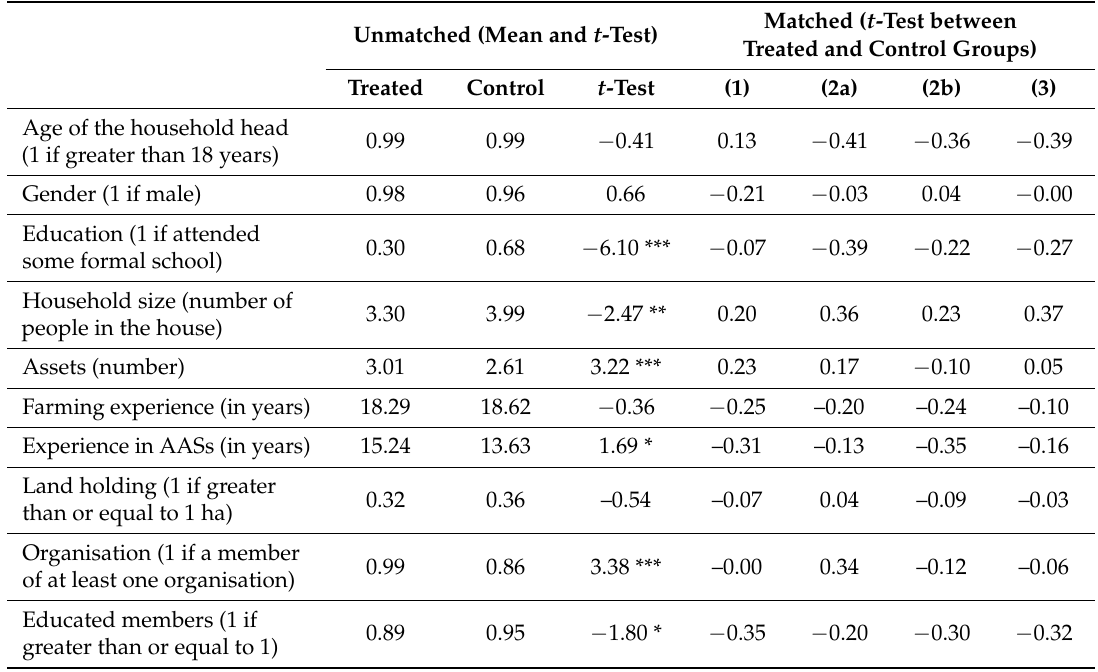
Table 6. Matching quality analysis: t -test results before/after matching. Matched ( t -Test between Unmatched (Mean and t -Test) Treated and Control